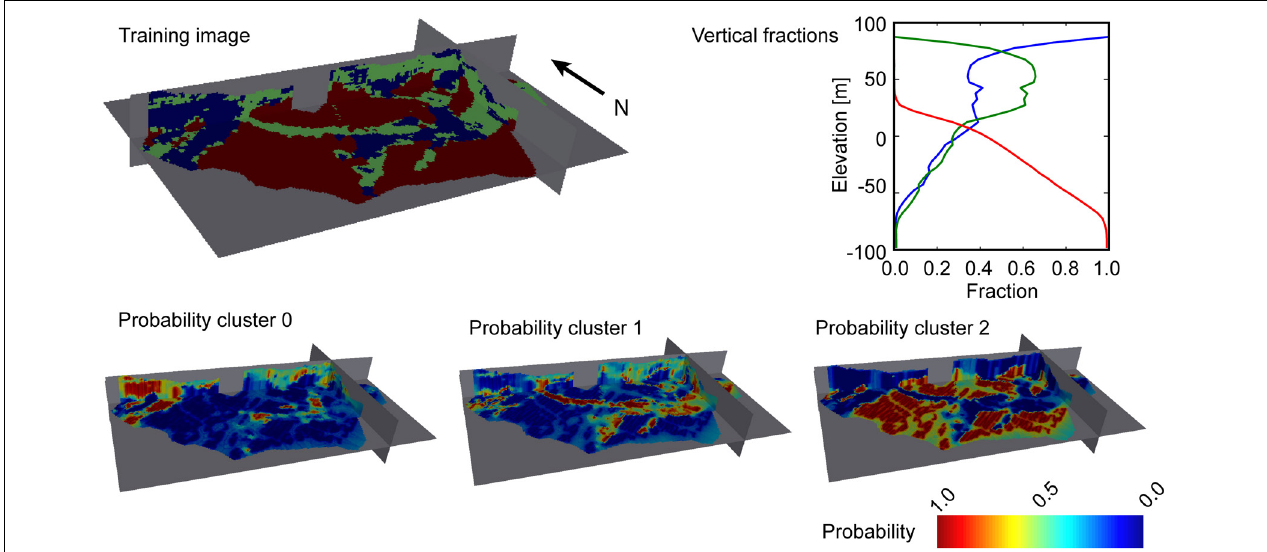
FIGURE 5 | Example of the MPS inputs needed in the analysis. The figure shows the data derived TI, the vertical proportions obtained from the cluster analysis and the cluster probabilities derived from the conditional probabilities estimated based on the histograms in Figure 3A .